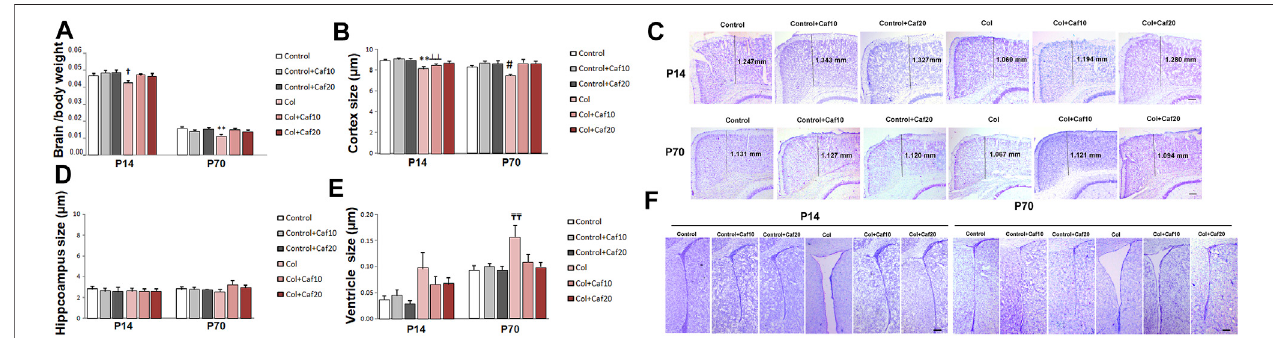
FIGURE 2 | Brain atrophy was improved by Caf treatment. (A) Brain/body weight ratio was reduced in mice with GM-IVH, and this effect was limited by Caf treatment, at both 10 and 20 mg/kg/day in the short term [F (2,87) = 4.24 and † p = 0.017 vs. Control, Control + Caf10 and Control + Caf20]. Data are representative of 9 – 21 mice (Control n = 16, Control + Caf10 n = 19, Control + Caf20 n = 18, Col n = 13, Col + Caf10 n = 13, and Col + Caf20 n = 17). Brain/body weight ratio was still